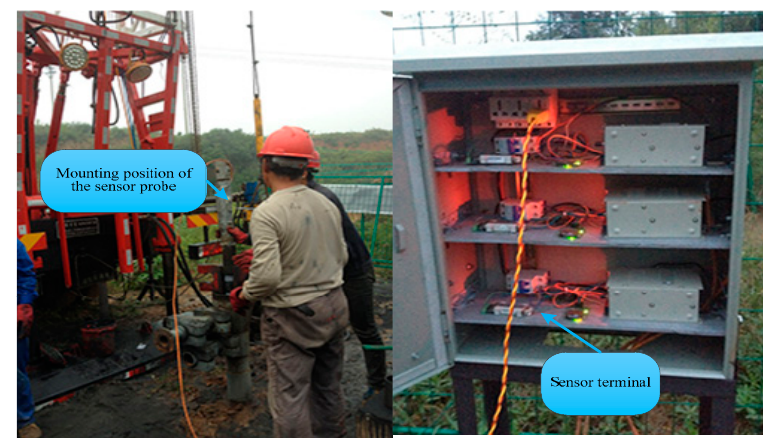
Figure 15. Test on site. Figure 15. Test on